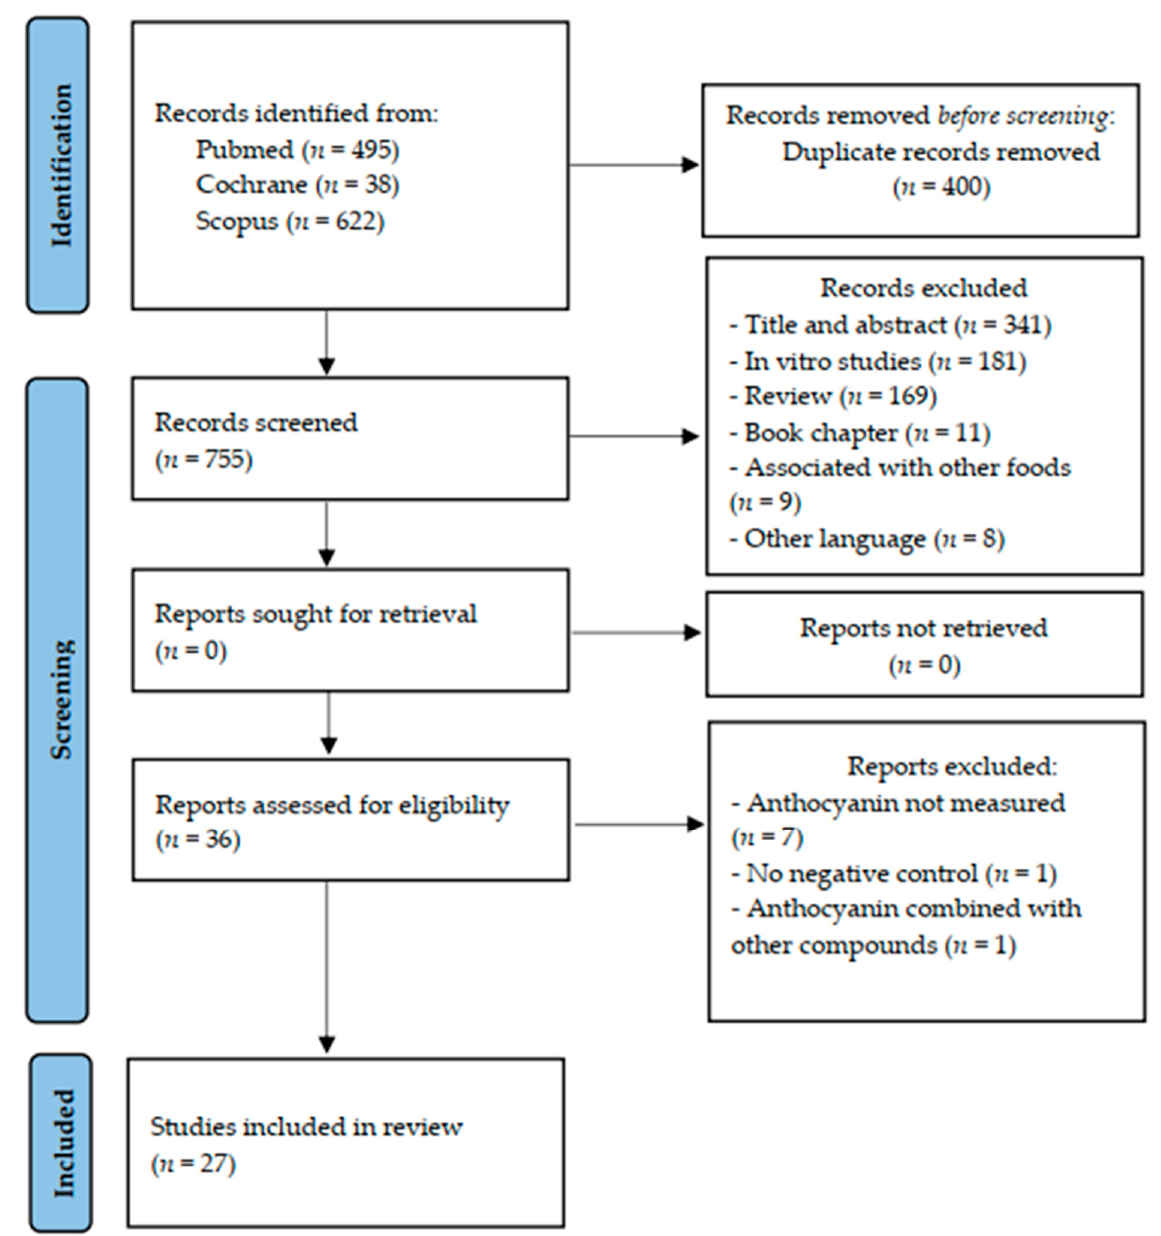
Figure 1. Flowchart of the search for articles included in the systematic review, according to PRISMA (2020) recommendation. The anthocyanin intervention varied by the source that was used. In 20 studies, diverse fruits were offered in the form of extract ( n = 12) [17,19,25,30,32–36,40,41,43], or as a powder ( n = 8) [22,26,28,31,37–39,42]. The fruits used as an anthocyanin source were chokeberry, Kamchatka berry, apple, blackcurrant, bilberry, blueberry, black raspberry, red cabbage, grape, berry juçara, jabuticaba, purple carrot, black gojy berry and black rice. In four studies, the intervention was with purified anthocyanin [20,23,24,27], and in three studies with monomeric anthocyanidins as cyanidin-3-O-glucoside [18], malvindin-3- glucoside [29] and pelargonidin-3-O-glucoside [21]. The form of anthocyanin administration was oral in all included studies, with the form of administration by addition in the diet ( n = 20) [18,22,24–33,35–40,42,43], or via gavage ( n = 5) [17,19,21,23,34] or drinking water ( n = 2) [20,41]. The duration of interventions ranged widely from 1 to 20 weeks. Regarding the anthocyanin dosage, the doses observed varied from 12.9 mg/100 g diet [42] to 1280 mg/100 g diet [40], and 1.68 mg/kg